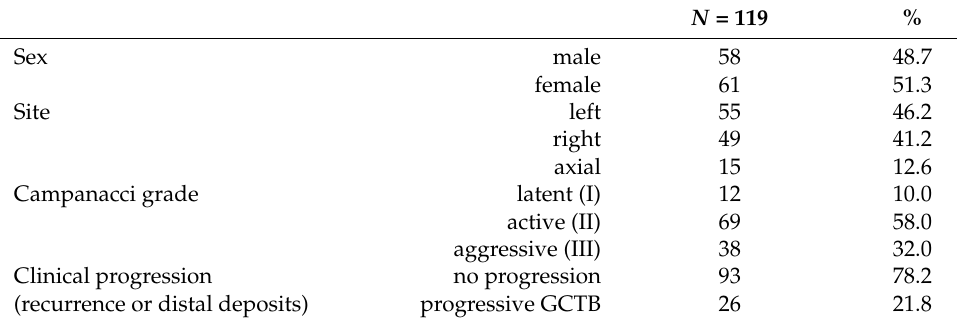
Table 1. Characteristics of GCTB study group.